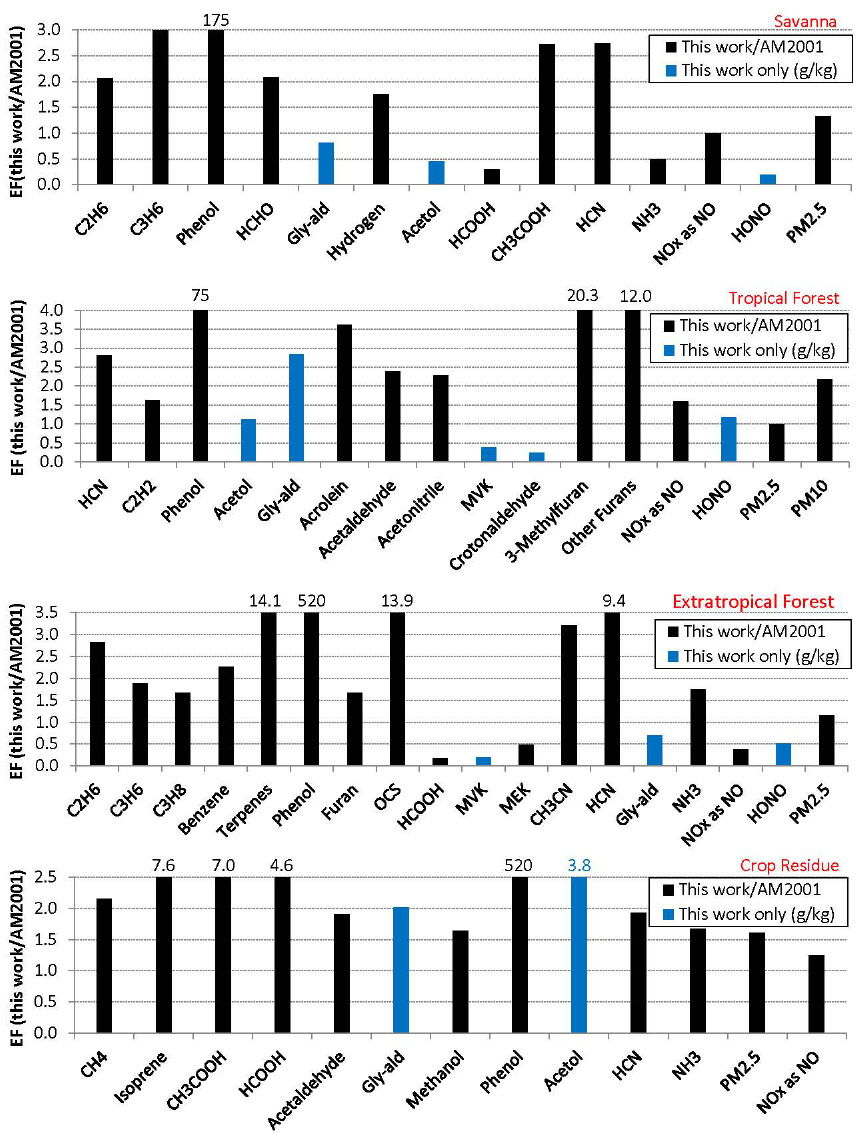
Fig. 1. The black columns show the EF in this work divided by the EF in Andreae and Merlet (2001) for the indicated species. The blue columns show the EF in gkg − 1 for species not found in Andreae and Merlet (2001). “Gly-ald”, “MVK”, and “MEK” indicate glycolaldehyde, methyl vinyl ketone, and methyl ethyl ketone, respectively. See Sect. 3.1 for